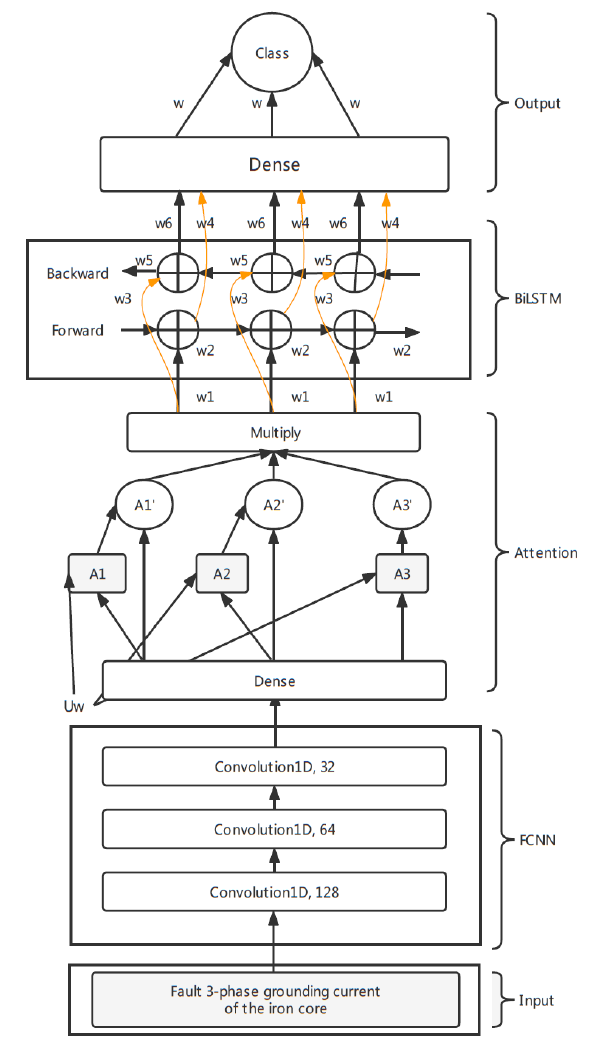
Figure 4. Model Architecture of